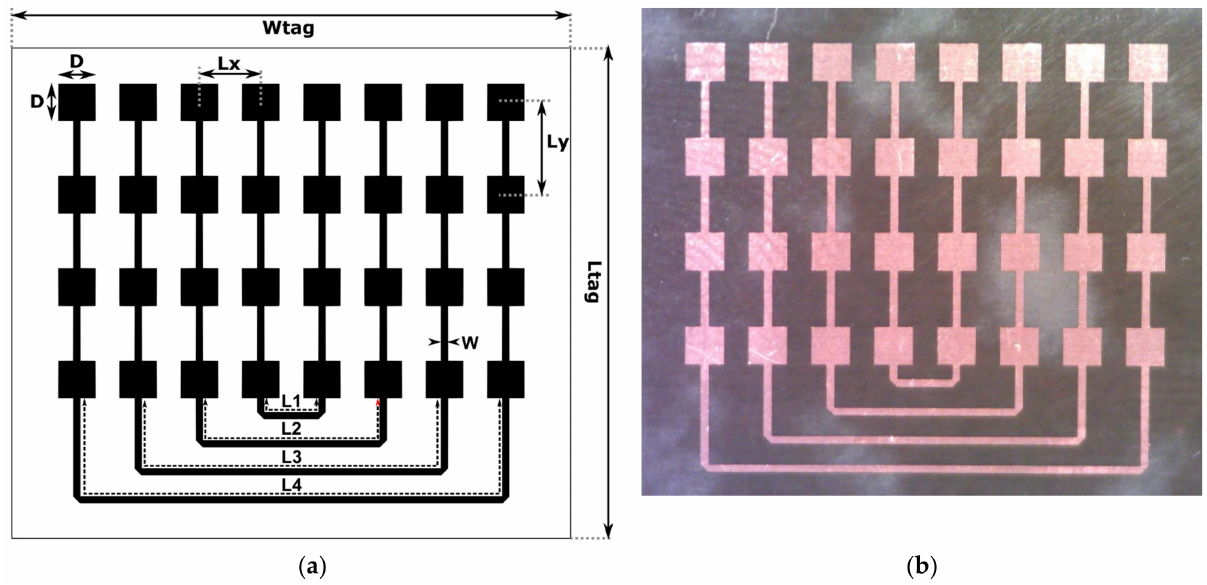
Figure 3. The co-polarized Van Atta arrays: ( a ) design and dimensions, and ( b ) photograph of the manufactured tag.